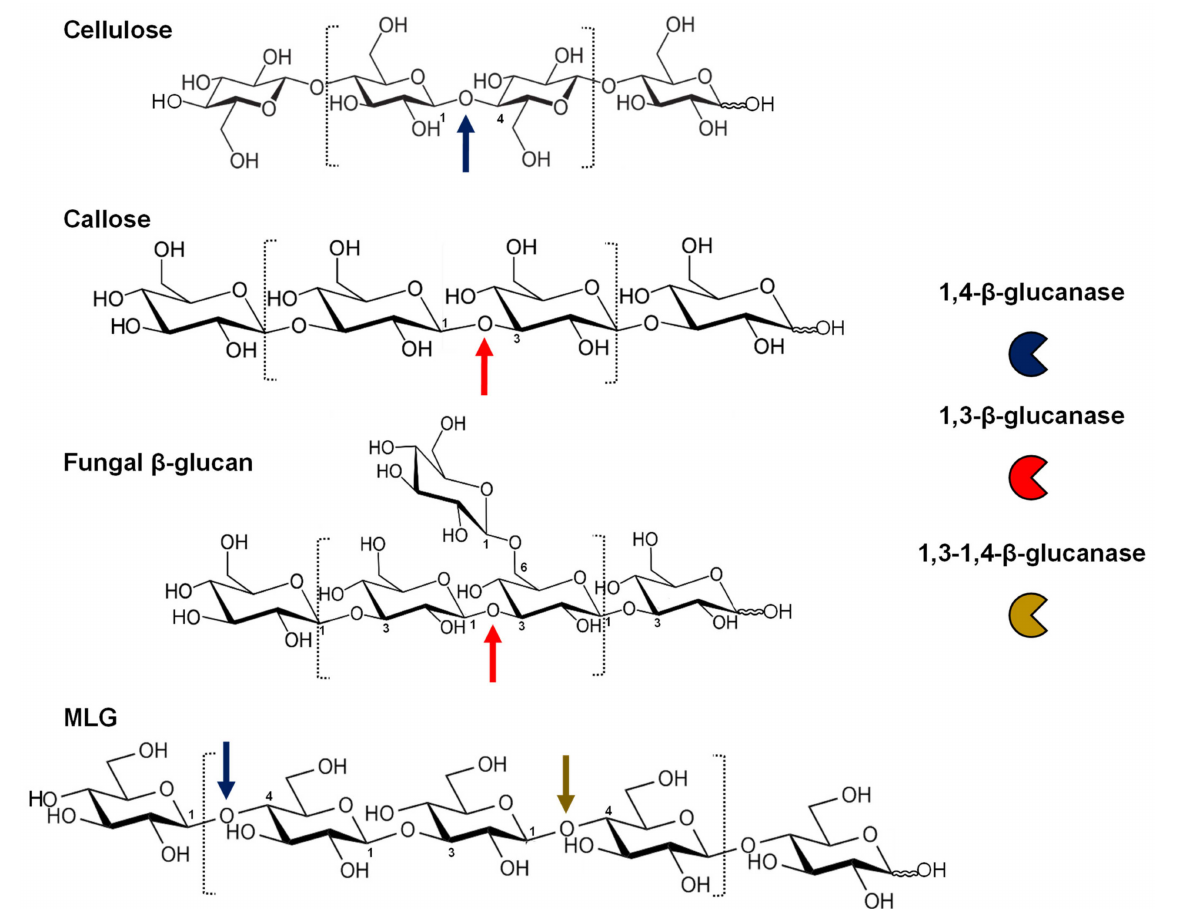
Figure 1. Activity of the three types of β -glucanases found in plants and their main physiological substrates. (1,3)- and (1,4)- β -glycosidic linkages are depicted as 3 and 4, respectively. Arrows indicate the glycosidic linkage hydrolysed in each